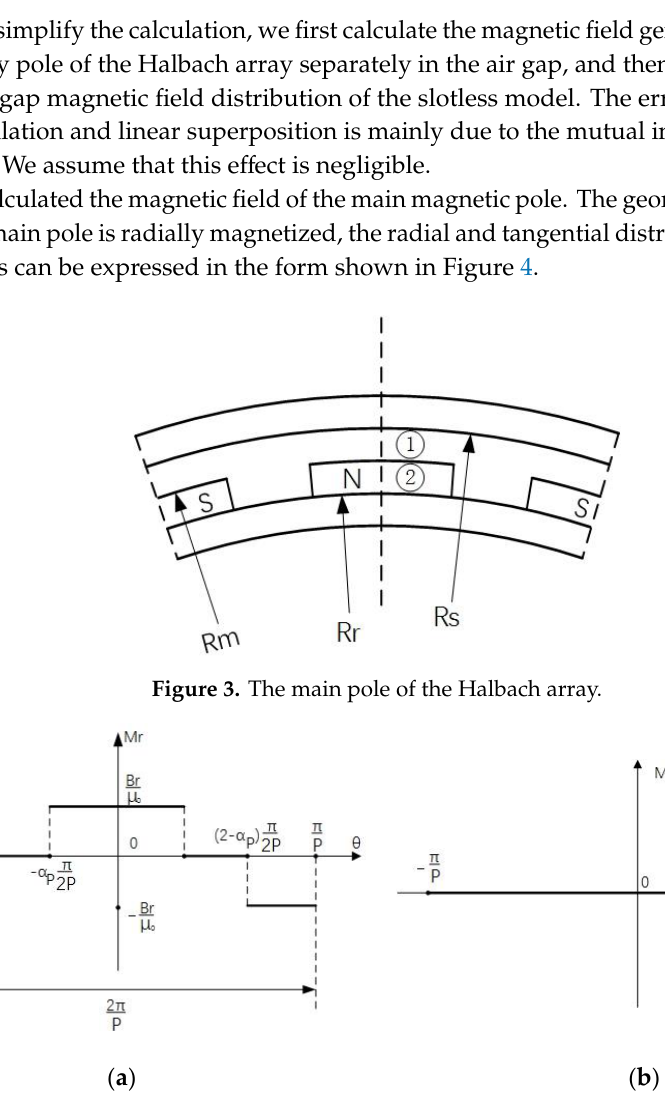
Figure 4. Magnetization distribution of the main pole: ( a ) the radial component of magnetization and ( b ) the tangential component of magnetization.